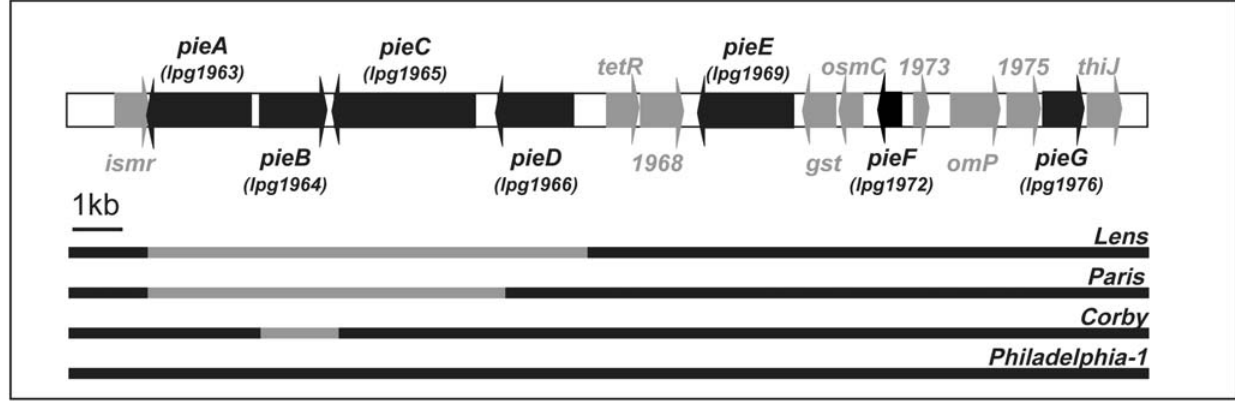
Figure 1. High genomic plasticity in the region encoding lpg1965. The Philadelphia1 genomic region flanking lpg1965 ( pieC ) was analyzed to obtain the specific genomic context of pieC . ORFs of novel translocated effectors are shown in black. Below is a low-resolution sequence alignment of this region, to scale, of all four sequenced genomes. Regions absent from the genomes of Lens, Paris and Corby are highlighted with grey bars.